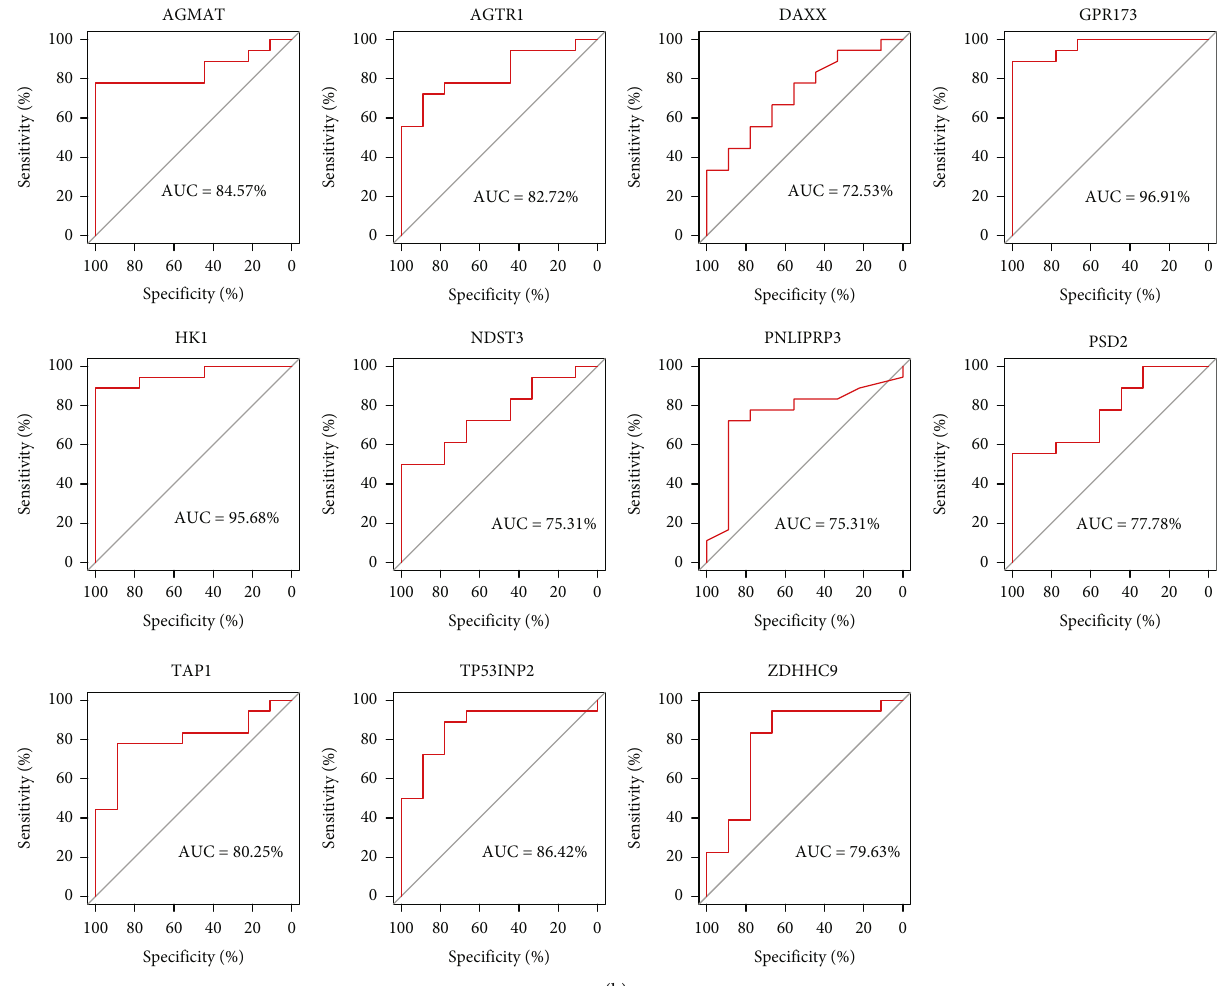
Figure 5: Screening analysis of correlated target genes: (a) box line plot of 24 genes expressed in acute, chronic heart failure and healthy groups (ANOVA, ∗ P < 0 : 05 ; ∗∗ P < 0 : 01 ; ∗∗∗ P < 0 : 001 ; and ∗∗∗∗ P < 0 : 0001 ); (b) construction of diagnostic models for 11 key